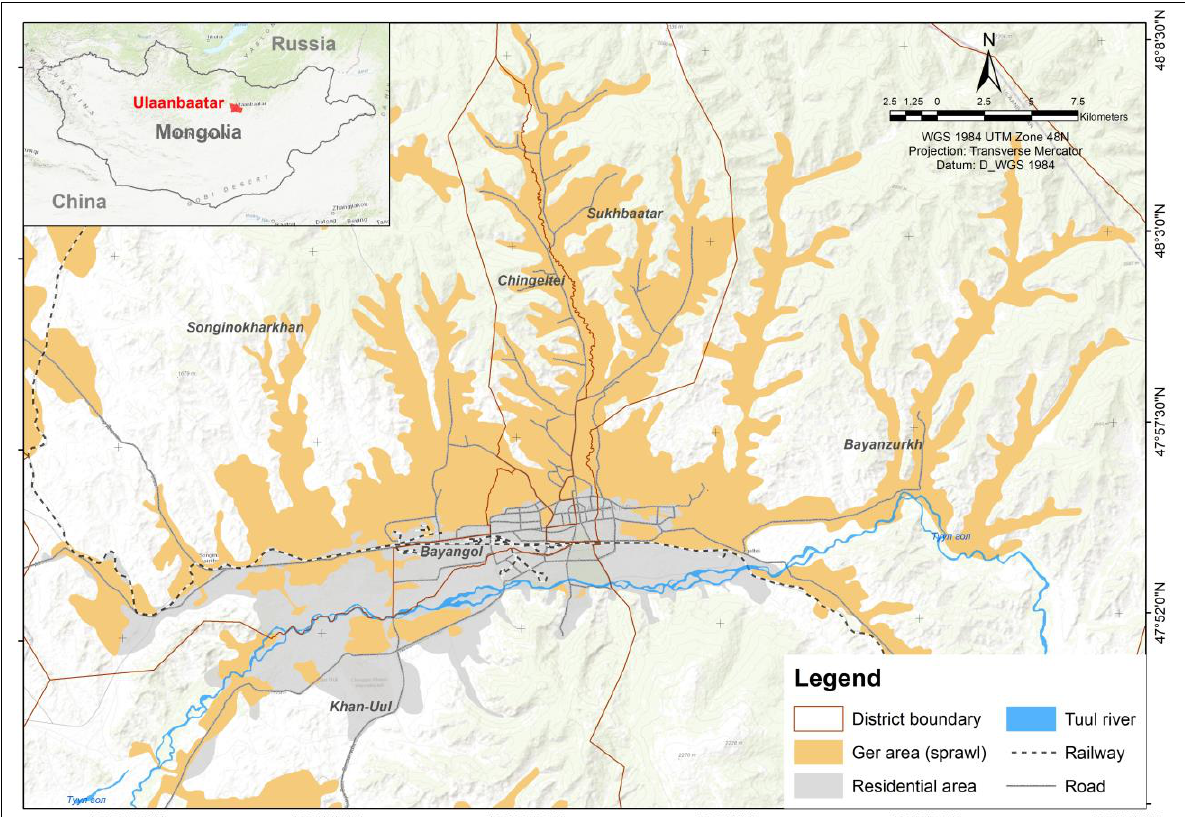
Figure 1. Location map of the study area (sprawl), Ulaanbaatar city,